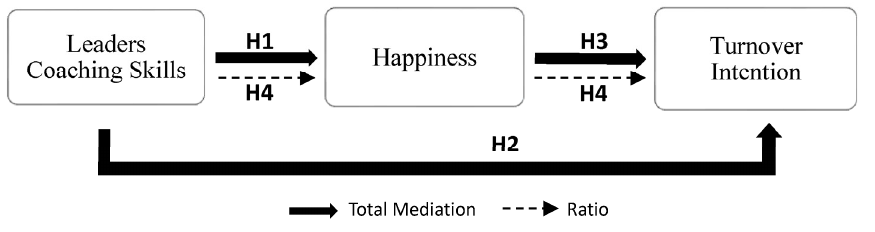
Figure 1. Conceptual model.